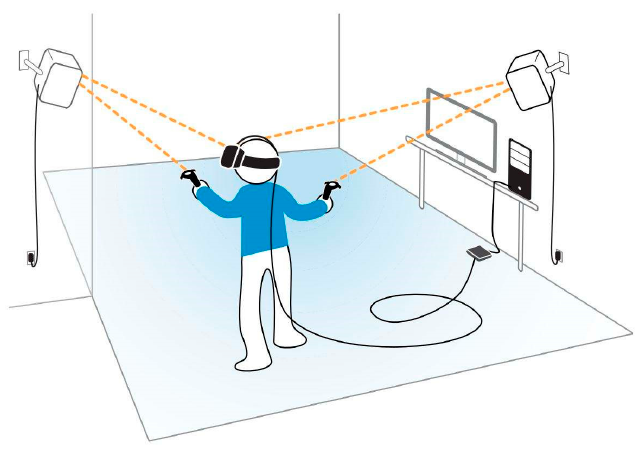
Figure 4. Optical positioning schematic of HTC VIVE.